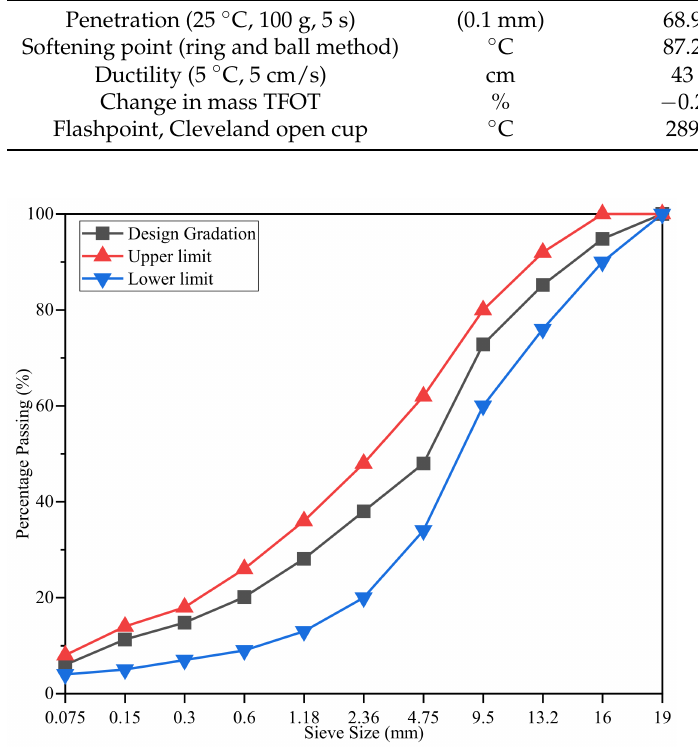
Figure 1. Aggregate gradation curves of AC 16. Table 2. Details of specimens for freeze–thaw